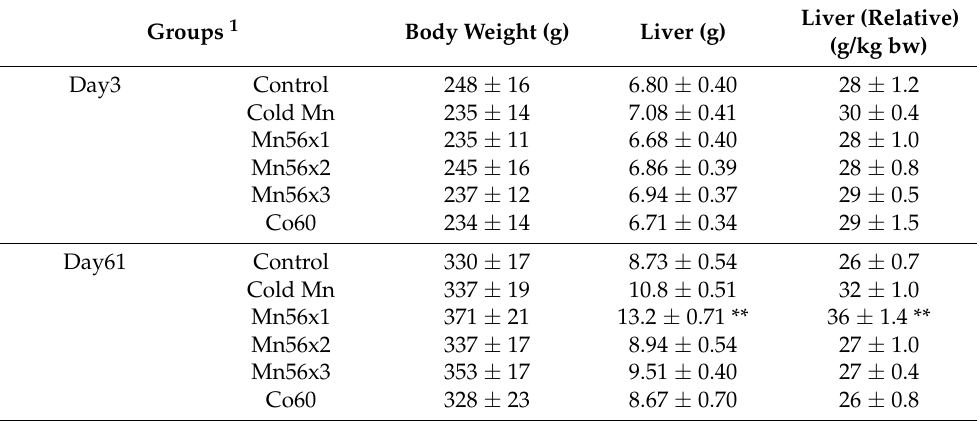
Table 2. Body and liver weights in rats exposed to 56 MnO 2 , 60 Co γ -rays, and cold MnO 2 . Groups